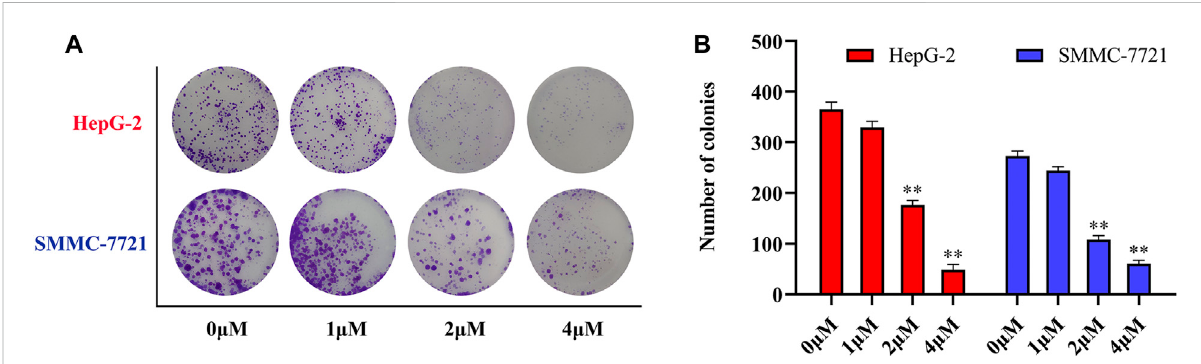
FIGURE 1 Compound 33 inhibits hepatocellular carcinoma (HCC) cell proliferation in vitro . (A) HepG-2 and SMMC-7721 cells were treated with different concentrations (0, 1, 2, and 4 μ M) of compound 33 to analyze colony formation. (B) Data are represented as the mean ± standard error of the mean (SEM) of three independent experiments. * p < 0.05, ** p <